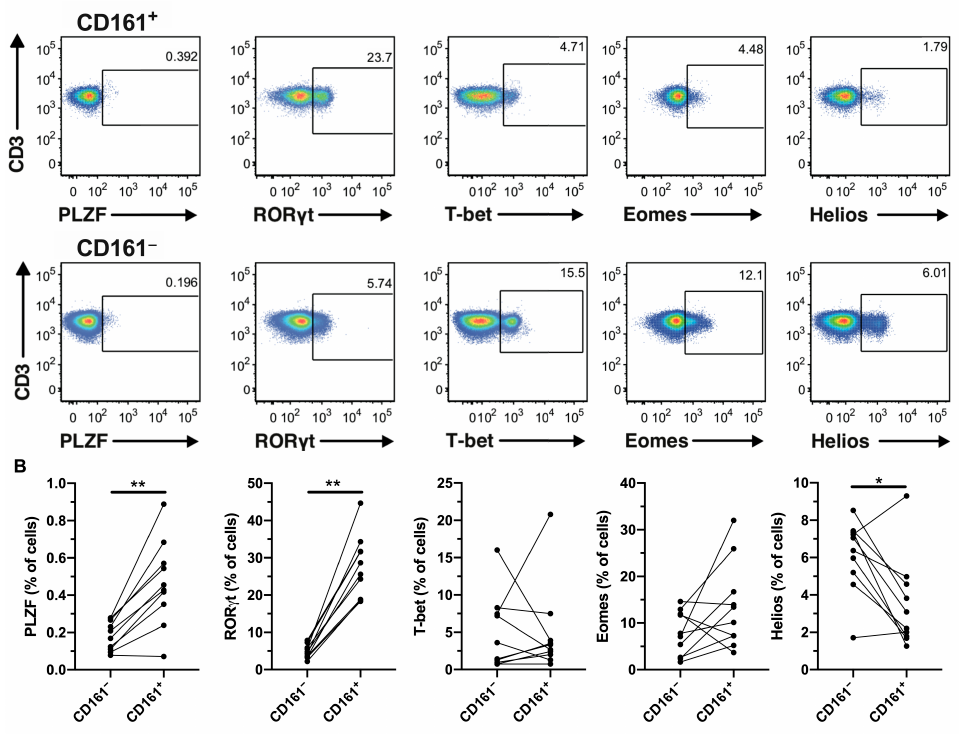
Figure 2. Transcription factors expressed by CD161 + CD4 + T cells. Representative flow plots showing expression of ROR γ t, PLZF, Helios, Eomes, and T-bet in CD161 + and CD161 − CD4 + T cells ( A ). Level of PLZF, ROR γ t, T-bet, Eomes, and Helios in CD161 + and CD161 − CD4 + T cells ( n = 10, B ). * p < 0.05 and ** p <